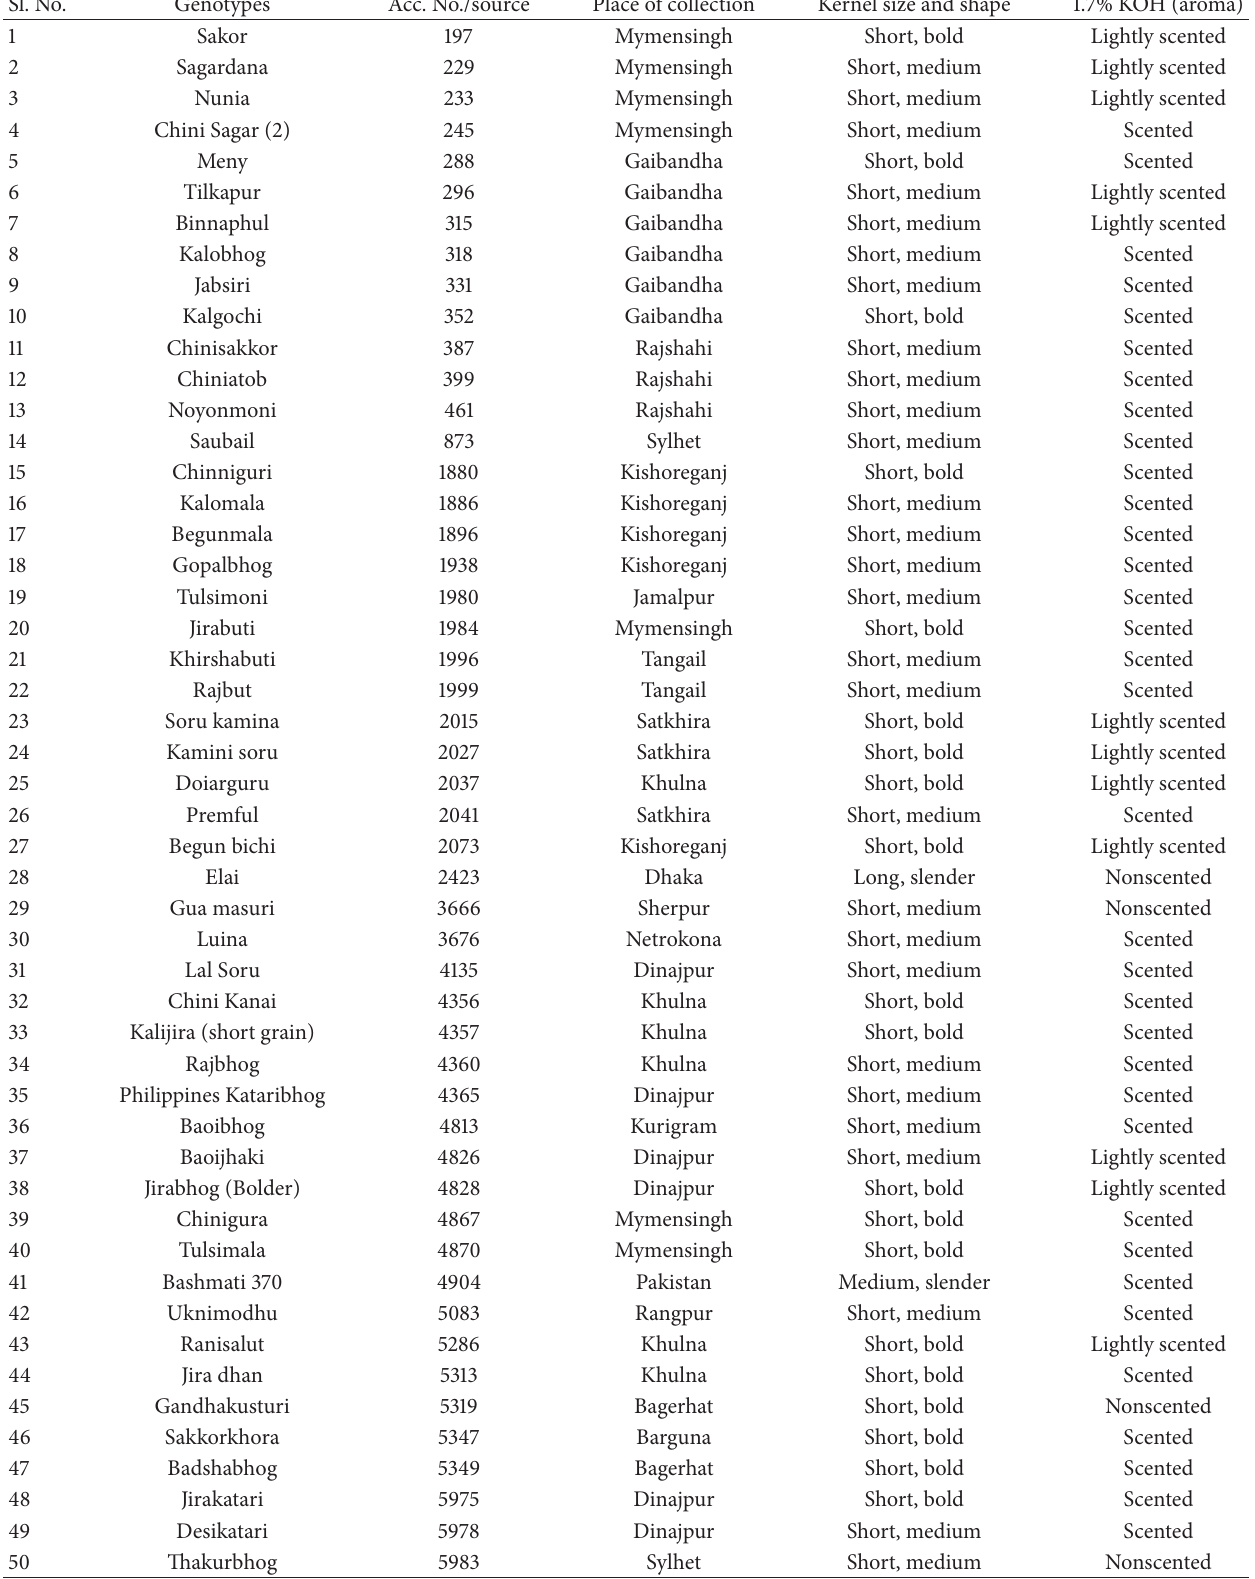
Table 1: Information on place of collection, source, and local name of the aromatic and fine rice accessions. Sl.